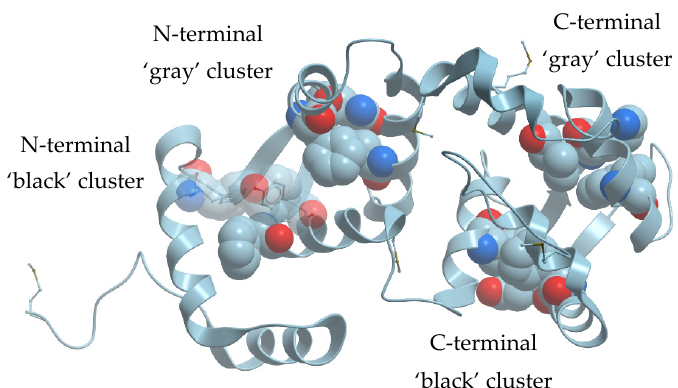
Figure 1. ‘Black’ and ‘gray’ clusters in the N- and C-terminal parts of human recoverin (Protein Data Bank (PDB) ID: 2D8N).